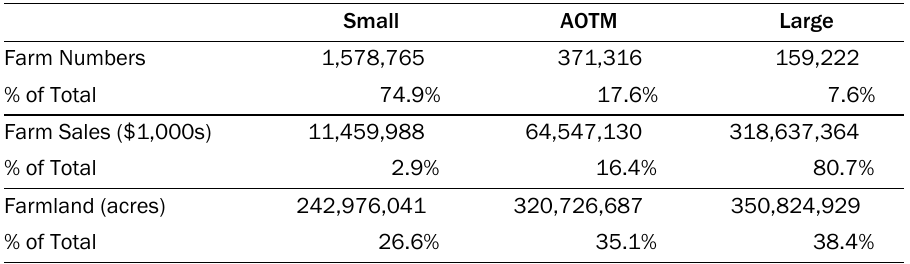
Table 1. Number of Farms, Farm Sales, Farmland by Sales Category for U.S. Farm Operations,